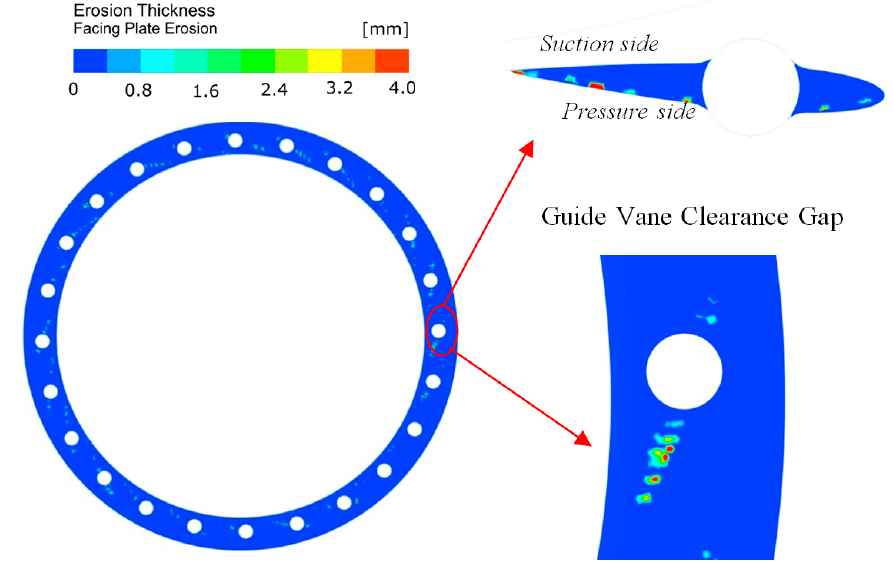
Figure 7. Thickness depletion in the facing plate.